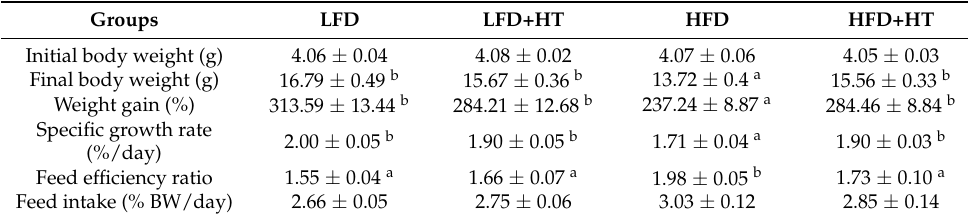
Table 3. Growth performance of blunt snout bream fed with experimental diets.